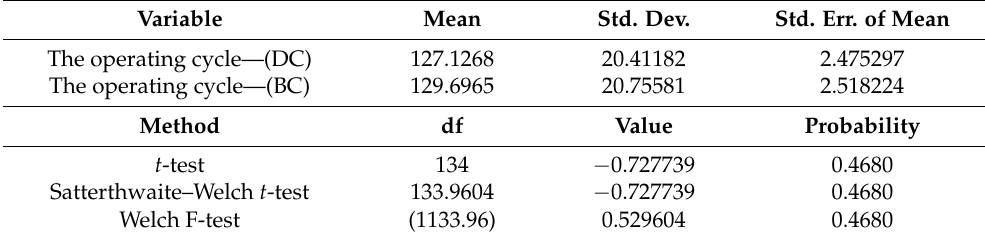
Table 11. The result of the operating cycle